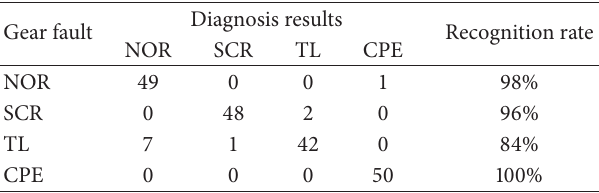
Table 3: Classification results with proposed method (DFA3). Table 4: Classification results with proposed method